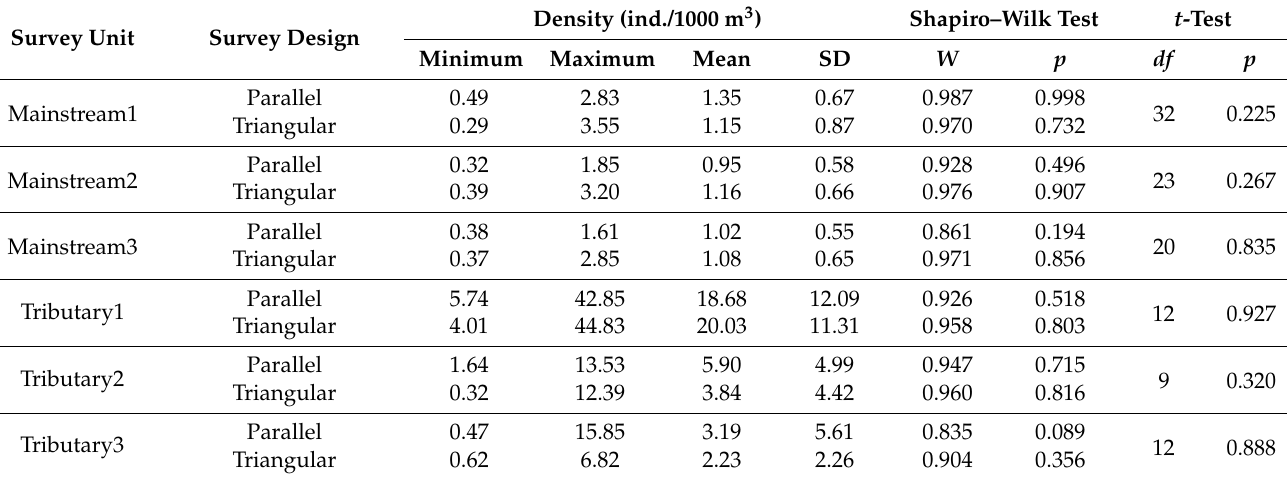
Table 2. Descriptive values of fish density estimate in the survey units of the mainstream and the tributary, with the statistics of the Shapiro–Wilk test and the t -test.